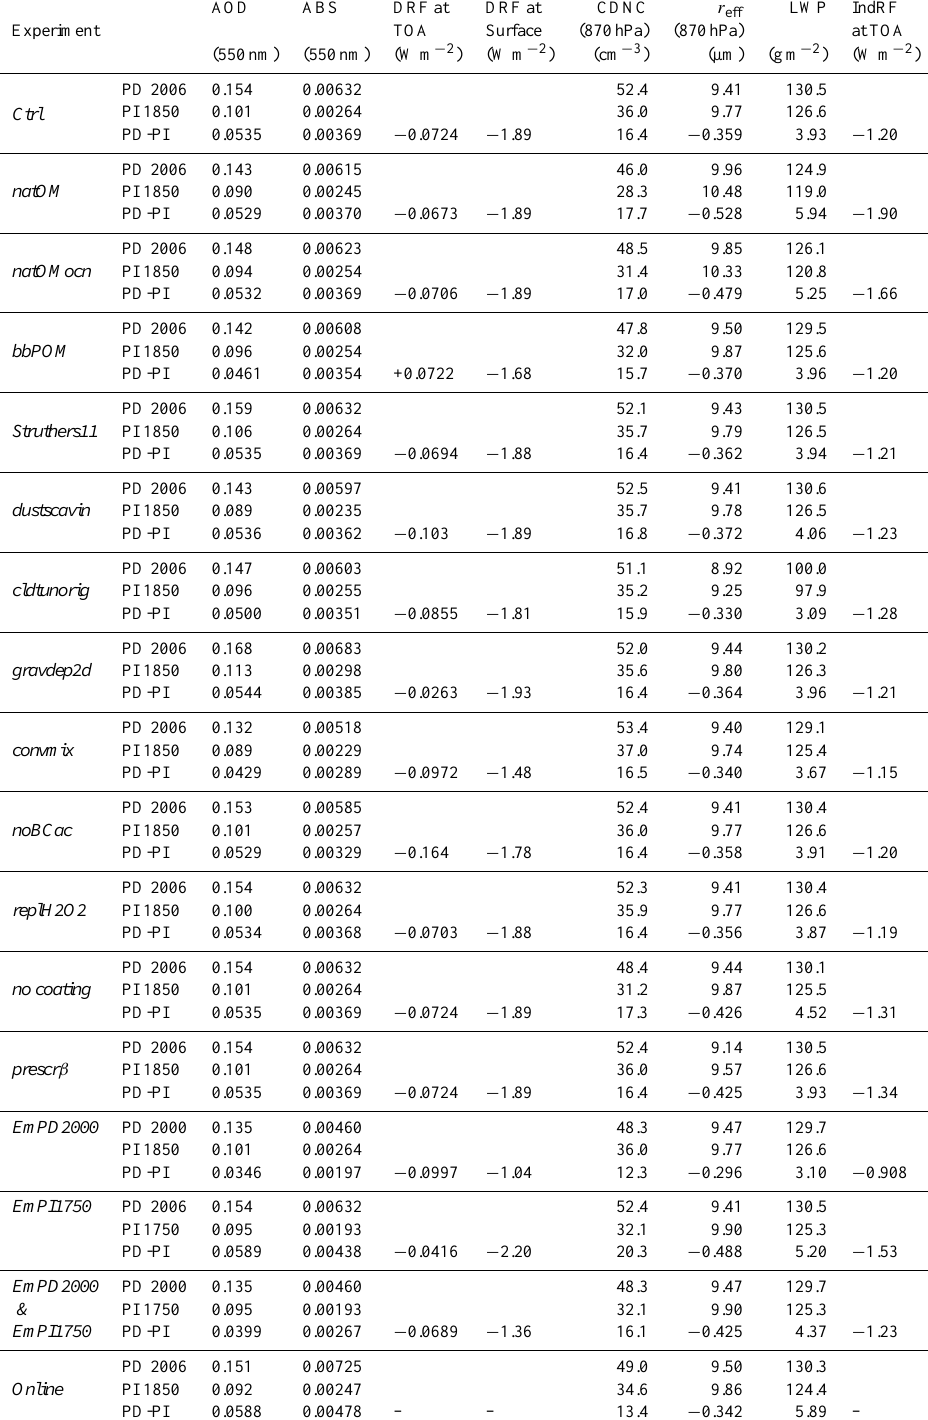
Table 7. Aerosol optical depth (AOD) and absorptive optical depth (ABS) at 550nm, top of the atmosphere direct radiative forcing (DRF), cloud droplet number concentrations (CDNC) and effective cloud droplet radii ( r eff ) at 870hPa, liquid water path (LWP), and indirect radiative forcing (IndRF) for Ctrl and the sensitivity experiments defined in Table 5. See the main text or Table 6 for the definition of simulation periods. DRF and IndRF are not estimated for the Online